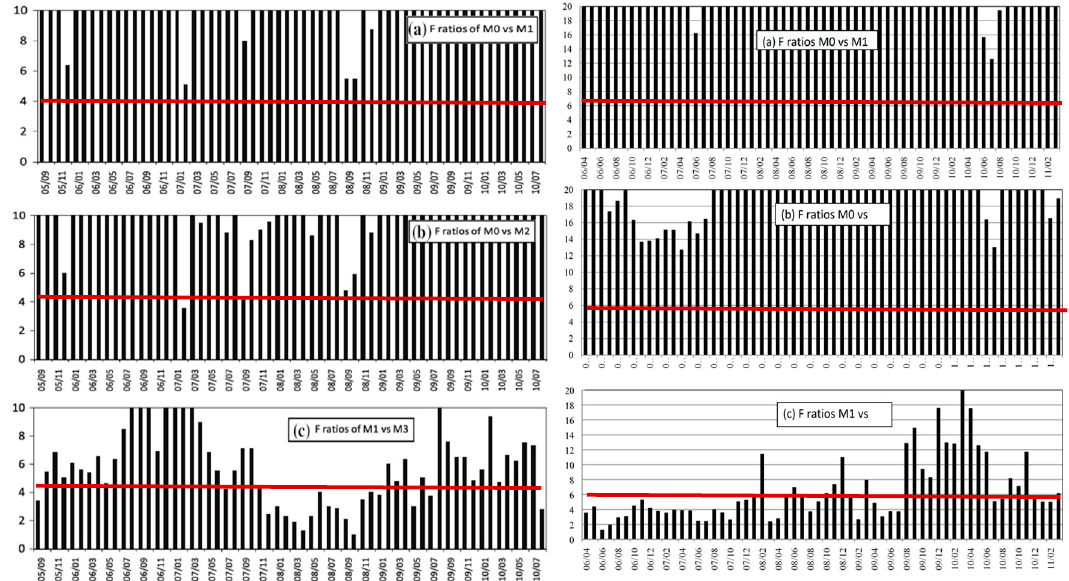
Figure 2. F -ratios of testing M0 vs. M1, M0 vs. M1, and M1 vs. M3. Graphs on left are Japanese government bond (JGB) cases for September 2005 through October 2010 (Kariya et al. 2012) and graphs on right are US GB cases for April 2006 through March 2011 (Kariya et al. 2016b).